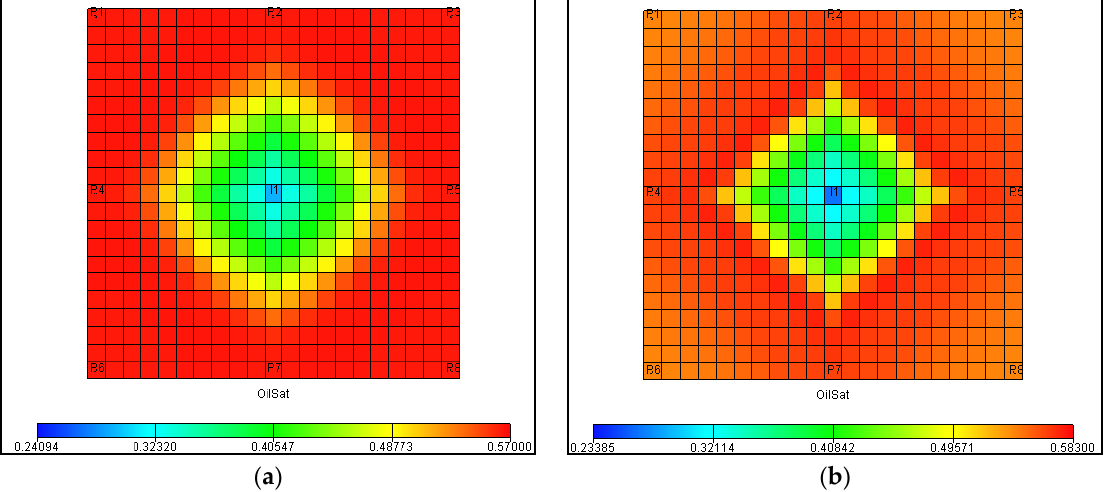
Figure 7. Residual oil saturation diagram on March: ( a ) Darcy seepage; ( b ) non-Darcy seepage.